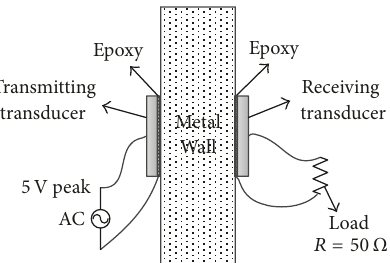
Figure 1: Diagram of the ultrasonic energy transmission channel formed by a pair of PZTs through a planar metal barrier.